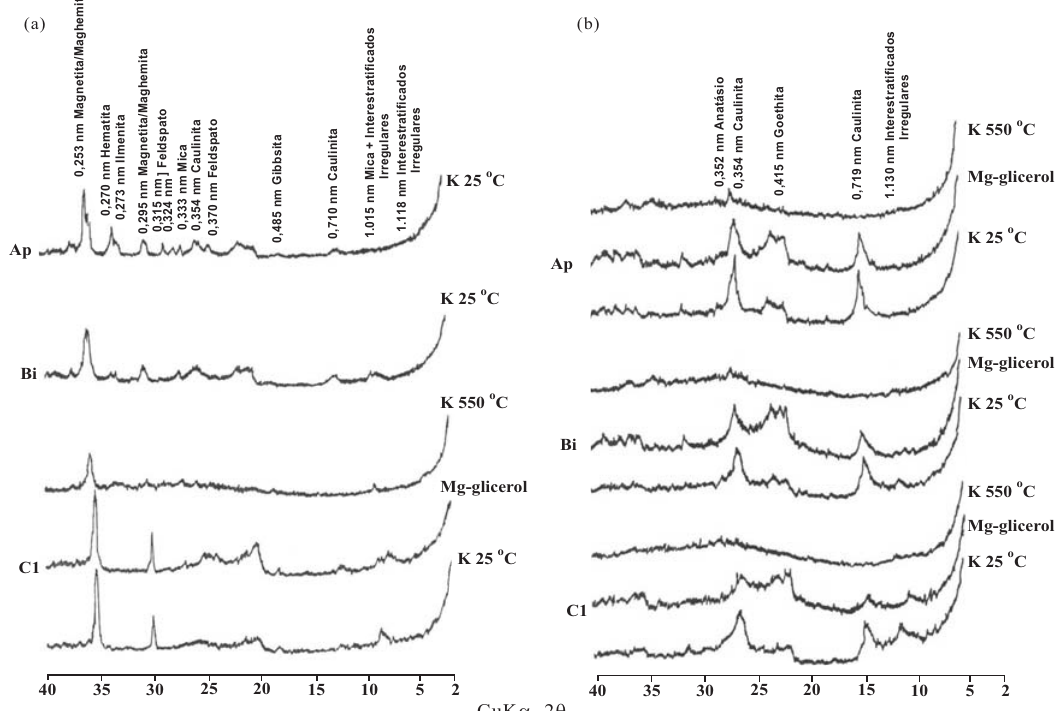
Figura 2. Difratogramas de raios X do perfil 2 – Cambissolo Háplico Ta eutroférrico típico. (a) fração silte; (b) fração argila.